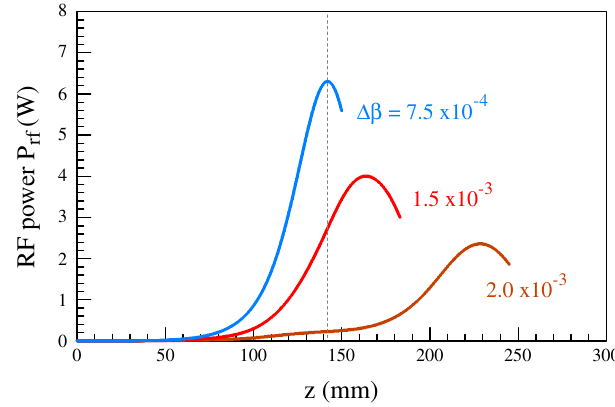
FIG. 11. (Color) (Injected beam energy matching rf frequency). The rf power profiles for different beam energies and rf power frequencies. The frequency bandwidth is 60 GHz ( (cid:1) 28% ) at FWHM.